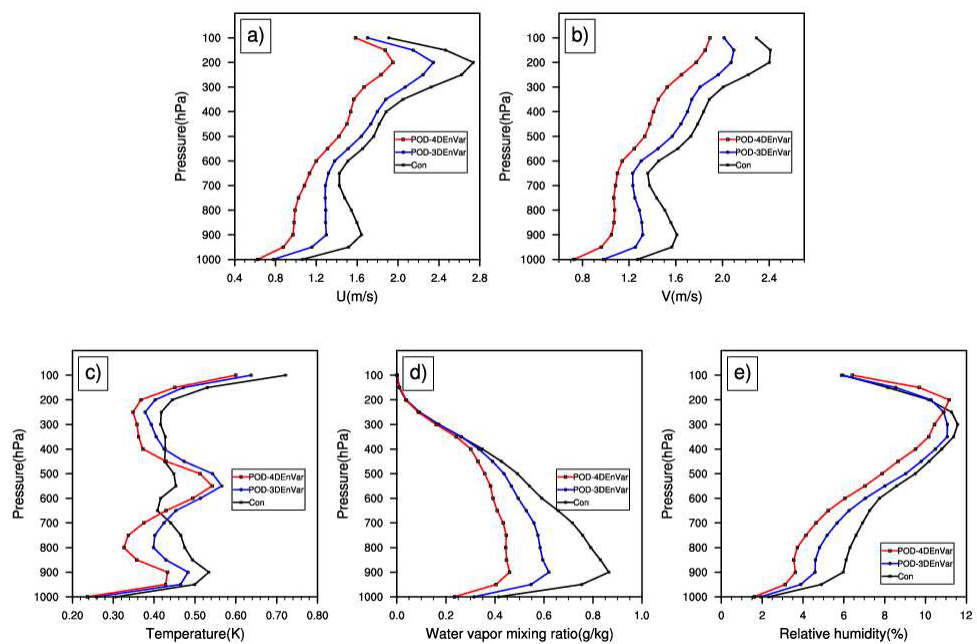
Figure 7. Vertical profiles of RMSEs in ( a ) u winds (unit: m s −1 ) ( b ) v winds (unit: m s −1 ) ( c ) temperature (unit: K) ( d ) water vapor mixing ratio (unit: g/kg) ( e ) relative humidity (unit: %) from Con, POD-3DEnVar, and POD-4DEnVar. Results are valid at 12:00 UTC on 29 June 2009 and are calculated for the whole horizontal domain.